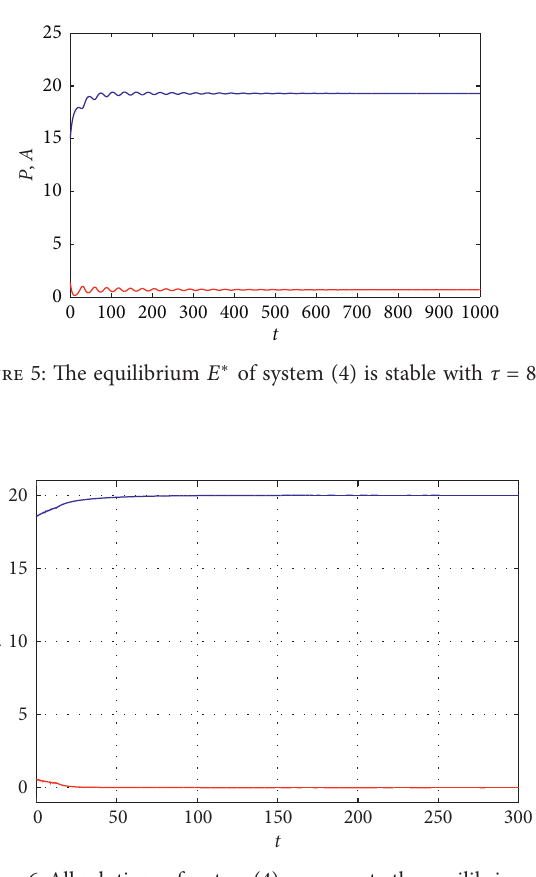
Figure 6: All solutions of system (4) converge to the equilibrium E with τ �